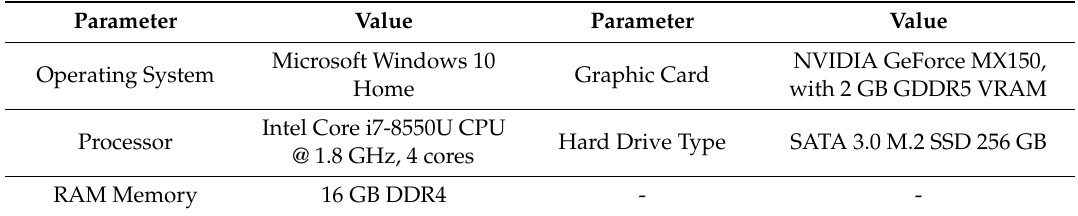
Table 1. The computer hardware used in the conducted research.